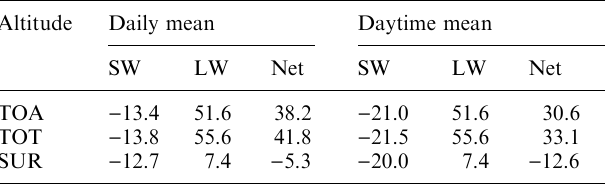
Table 3. Daily mean (24 h) and daytime mean (from sunrise to sunset) radiative flux changes in the midlatitude summer con- tinental case at top of the atmosphere (TOA, 50 km), top of troposphere (TOT, 12 km), and at the surface (SUR, 0 km) in Wm ) 2 . Results from model M for spherical particles Altitude Daily mean Daytime mean